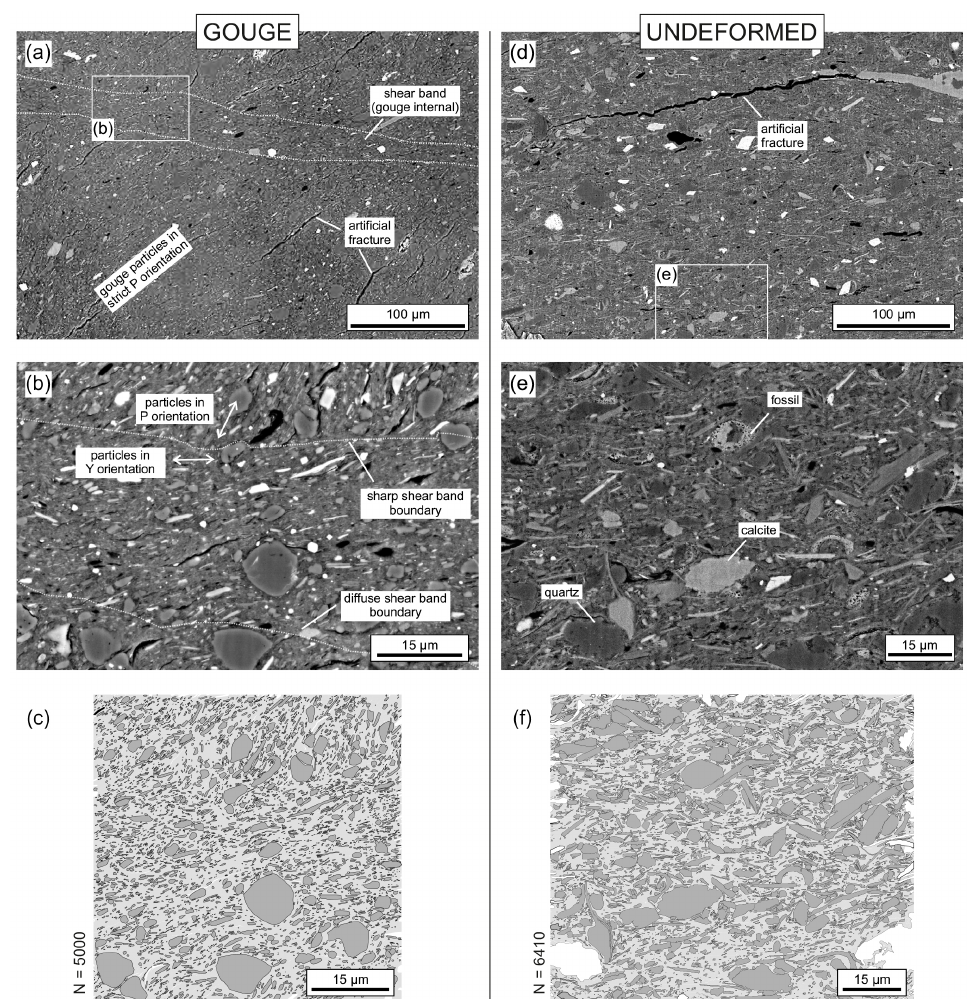
Figure 11. Comparison of the undeformed OPA (right, sample V08) to gouge fabric (left, sample V15-4) with grains in P foliation and with a 30µm wide shear band of differently oriented grains. All micrographs are recorded using a BIB-SEM (BSE). Panels (b) and (e) are insets of panels (a) and (d) , respectively. (c, f) Manually segmented grains used in statistical analysis (see Fig. 12). Zoom-in for full